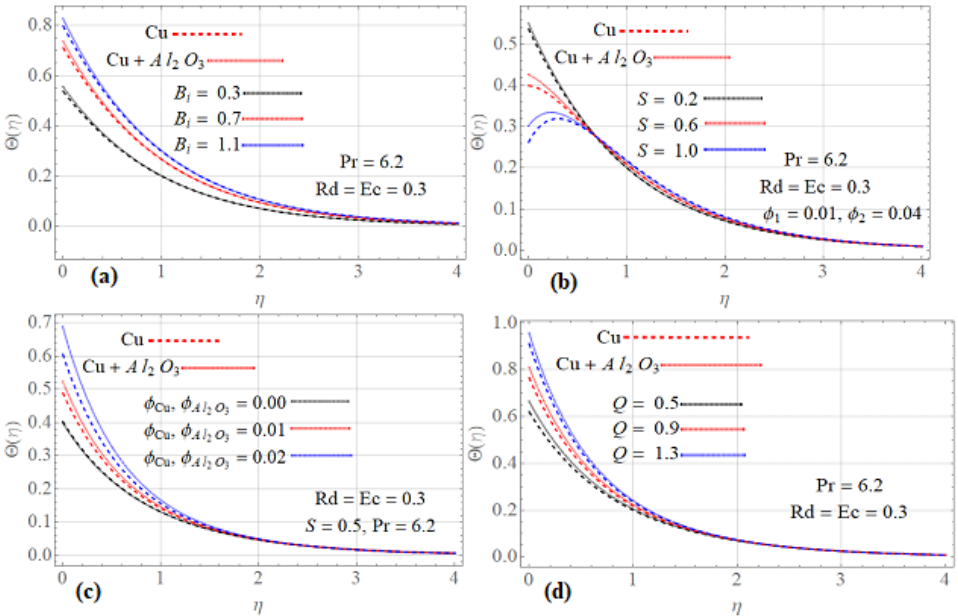
on F (cid:48) ( η ) for Cu + Al 2 O 3 / H 2 O versus Cu / H 2 O . 2 O 3